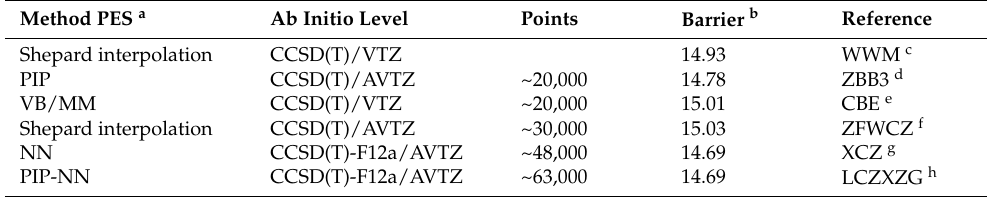
Table 1. Selected recent potential energy surfaces for the H + CH 4 reaction based on ab initio calculations.